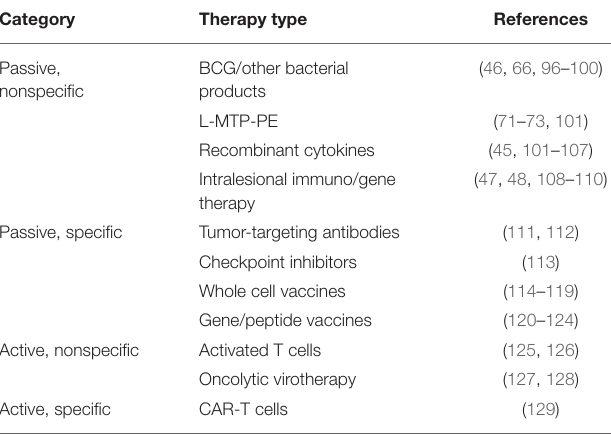
TABLE 1 | Immunotherapy approaches investigated in canine cancer